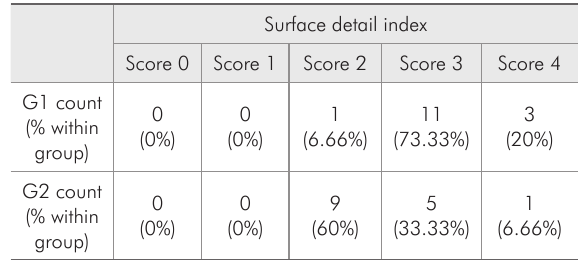
Table.2.- Frequency distribution of the surface detail index.